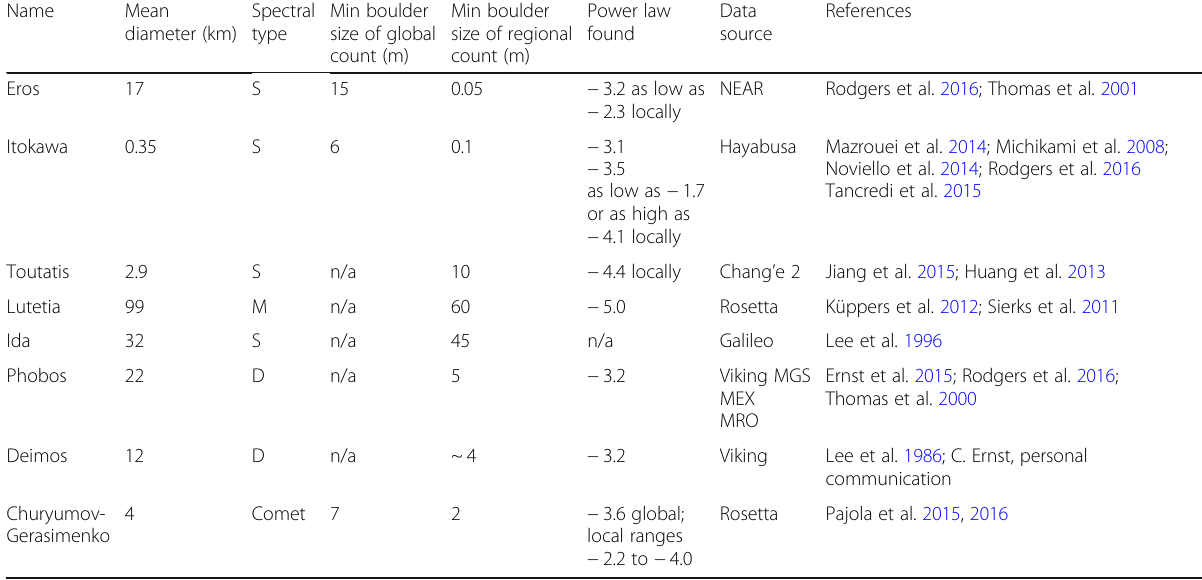
Table 5 Small bodies for which boulder counts have been made from spacecraft images. The minimum boulder sizes measured are directly related to the best image resolution available for a given